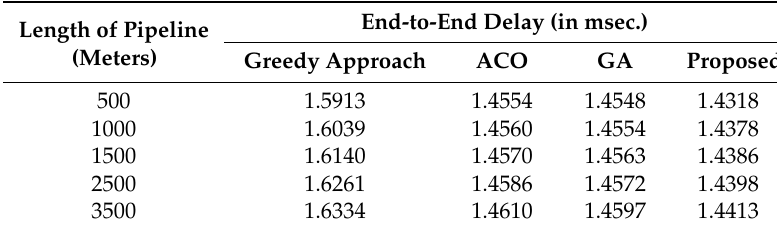
Table 2. Comparison of Delay (Range 25 m).